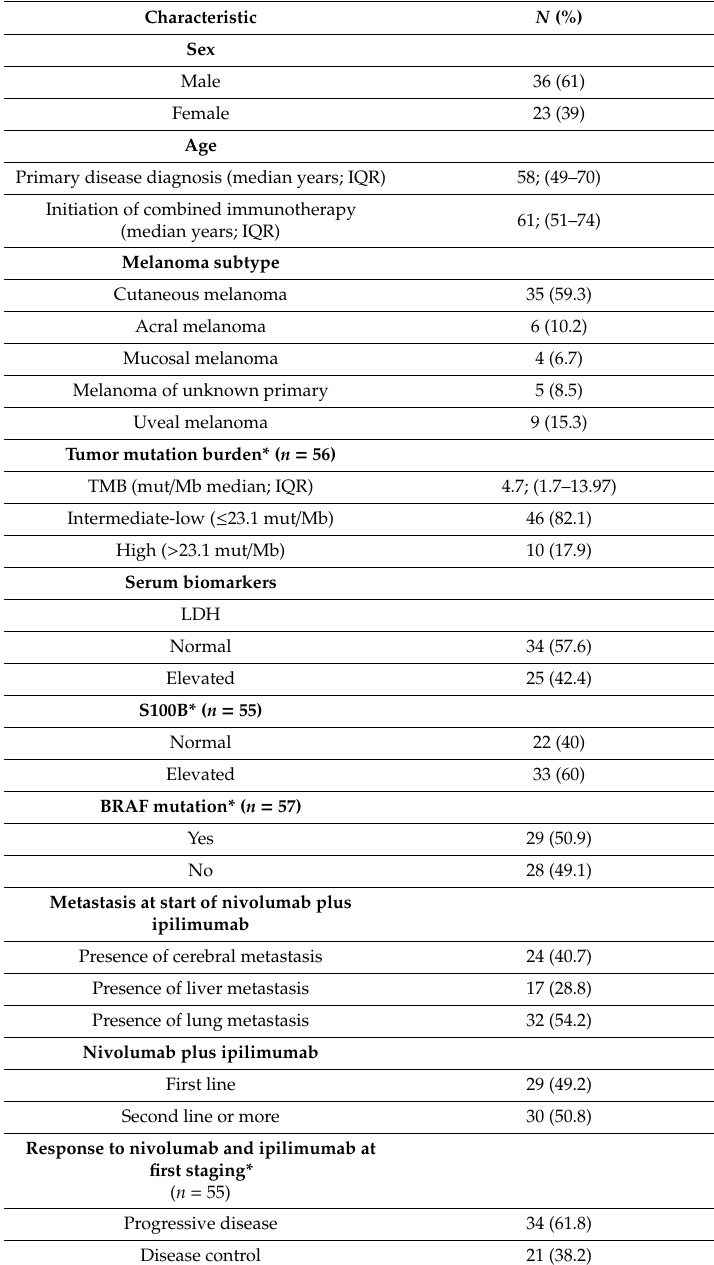
Table 2. Patients’